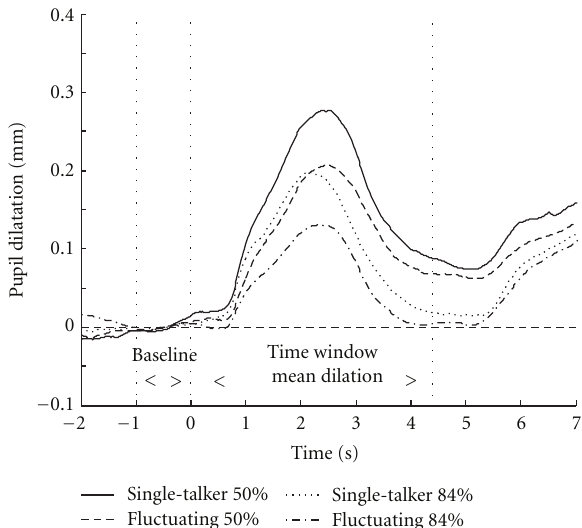
Figure 1: SRTs (dB SNR) at two intelligibility levels for both masker types, averaged over subjects. The error bars show the standard errors for each condition. Table 1: The average SRT scores, PPD, and the subjective ratings for both levels of intelligibility and for both masker types.